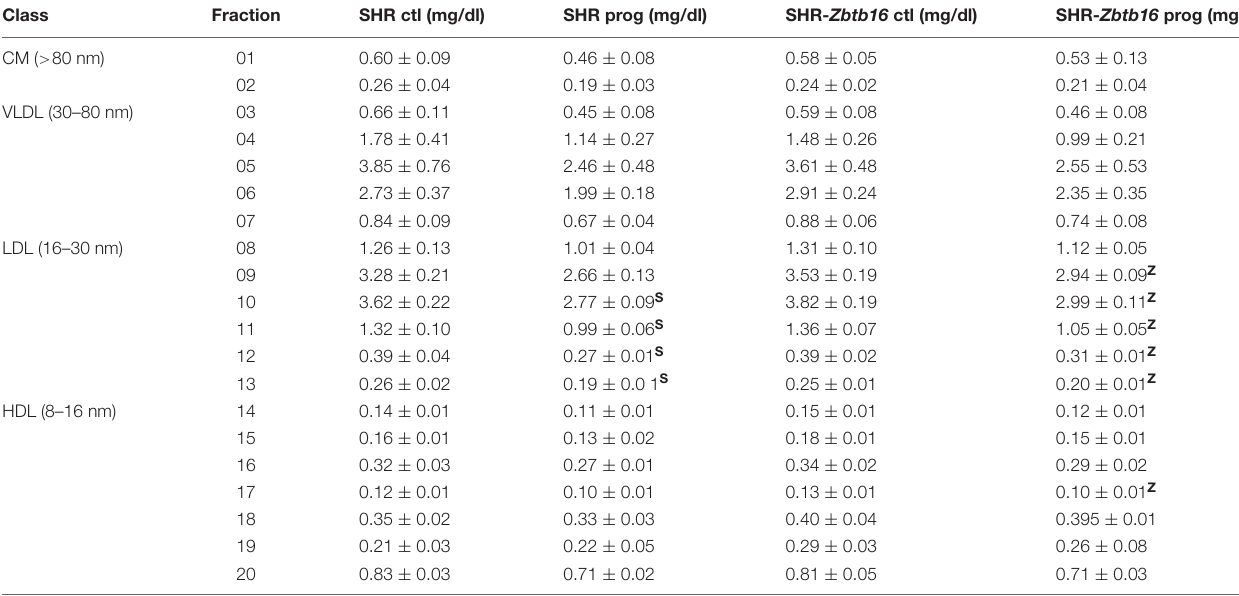
TABLE 2 | Triacylglycerol lipoprotein profile of control and programmed male offspring. Class